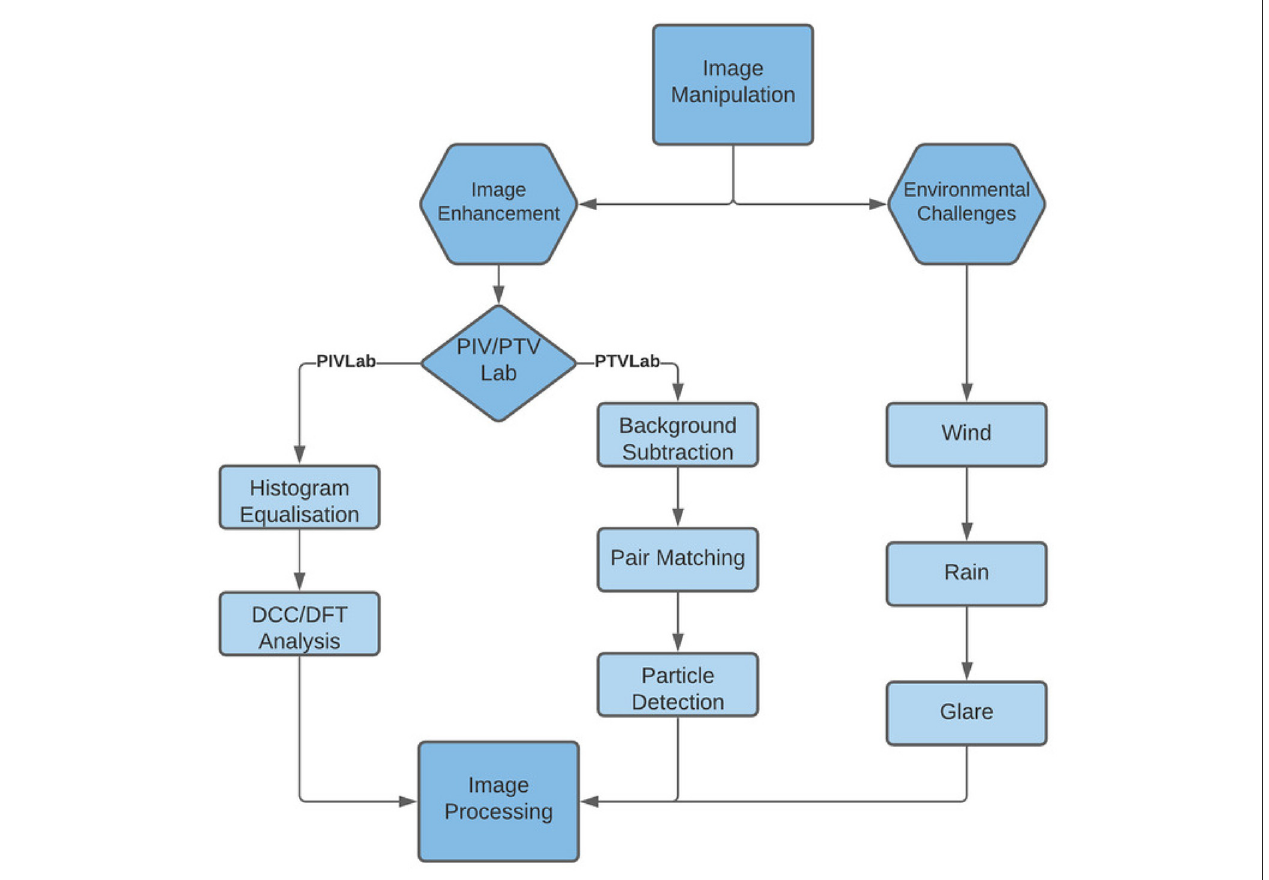
FIGURE 9 | A remodel of the Patalano et al. (2017) study, showing a flowchart for typical image processing sub-sequences with either PIVlab or